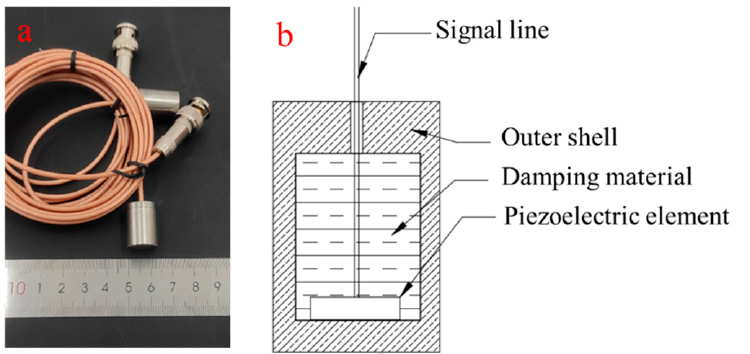
Figure 5. ( a ) The ultrasonic transducer and ( b ) the schematic diagram of the ultrasonic transducer. The working principle of ultrasonic detection is an instrument system that transmits an electric pulse to the transmitting transducer made of piezoelectric material, which excites a chip to vibrate, emitting waves that propagate through the test material. The waves are then received by the receiving transducer, which converts the energy into a weak electrical signal sent to the receiving system; then, the signal is amplified and the waveform is displayed on the screen after analog-to-digital conversion. The wave amplitude and first arrival time ( t ) are read from the waveform and used to calculate the longitudinal wave velocity ( V p ) of the ultrasonic wave propagating in the test sample from the known test sample distance ( L ), which is expressed as V p = L / t Before the experiment, it is necessary to perform a zero-time calibration test on the ultrasonic transducer using the direct docking method. The transmitting transducer and the receiving transducer are directly docked and stabilized, and the first arrival time of wave propagation is recorded; that is, a wave with zero delay t 0 in the measurement system. The result of the zero-wave calibration test for this experimental system is shown in Figure 6, which displays a very short time. More detailed results are shown in the partial enlargement of the first arrival time in the upper-right corner. Then, in this experimental system, the expression of longitudinal wave velocity was